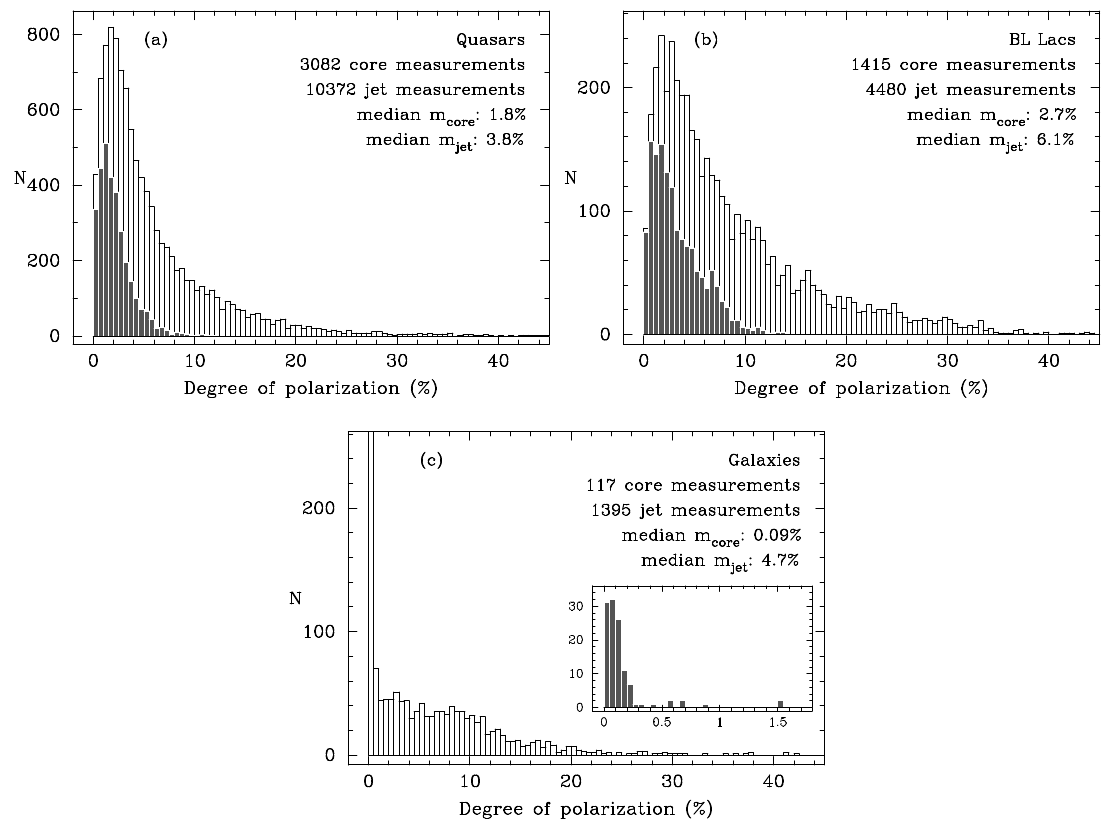
Figure 2. ( a ) Histograms of fractional polarization of core (filled gray bins) and jet components (empty bins) for quasars, ( b ) for BL Lacs, ( c ) for radio